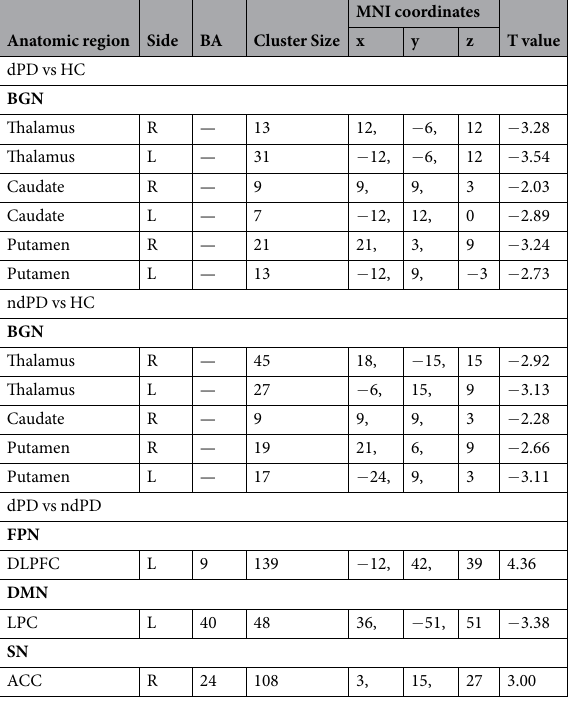
Table 3. Post-hoc comparison of intranetwork connectivity between dPD, ndPD and HC groups (two-sample post hoc t-tests, p < 0.05, topoFDR corrected). L, left; R, right; BA, Brodman area; MNI, Montreal Neuroscience Institute template; BGN, basal ganglia network; DMN, default-mode network; FPN, frontoparietal network; SN, salience network; LPC, lateral parietal cortex; DLPFC, dorsolateral prefrontal cortex; ACC, anterior cingulate